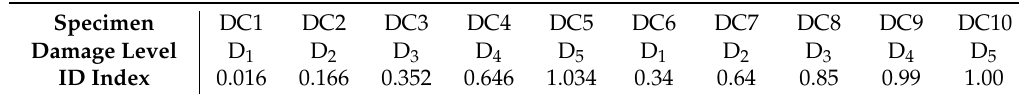
Figure 14. Mean and standard deviation of parameter E s . ( Left ) specimens subjected to incremental cyclic loading (DC1 – DC5), ( Right ) specimens subjected to constant cyclic loading (DC6 – DC10).